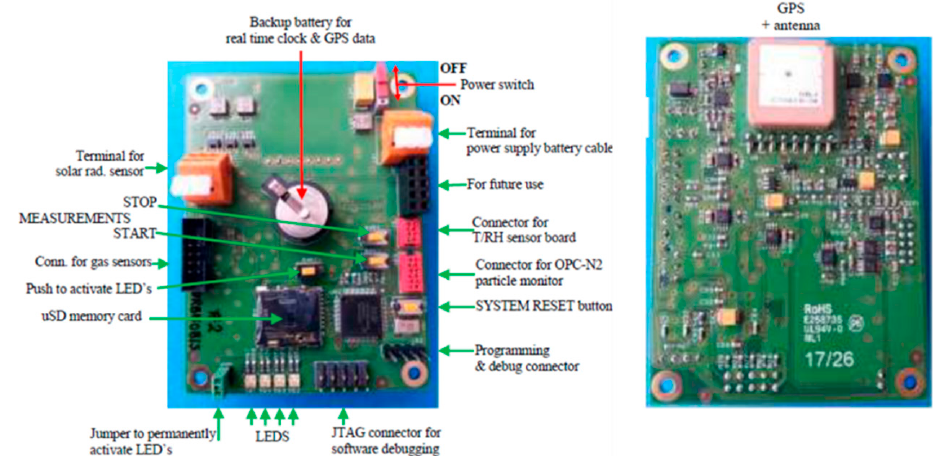
Figure 1. Printed circuit board (PCB), bottom-side ( left ) and top-side ( right ), of the URBMOBI 3.0 sensor-box. Photo: Evert Nieuwkoop.